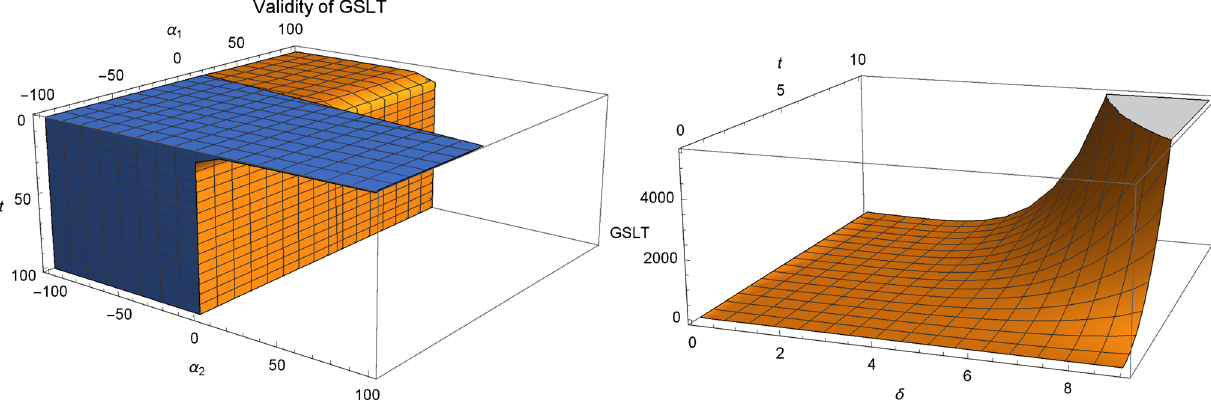
Fig. 3 Left plot represents the regions where GSLT is satisfied for δ = 10 in intermediate case and right graph corresponds to evolution of GSLT versus δ for α 1 = 0 . 2 and α 2 = −